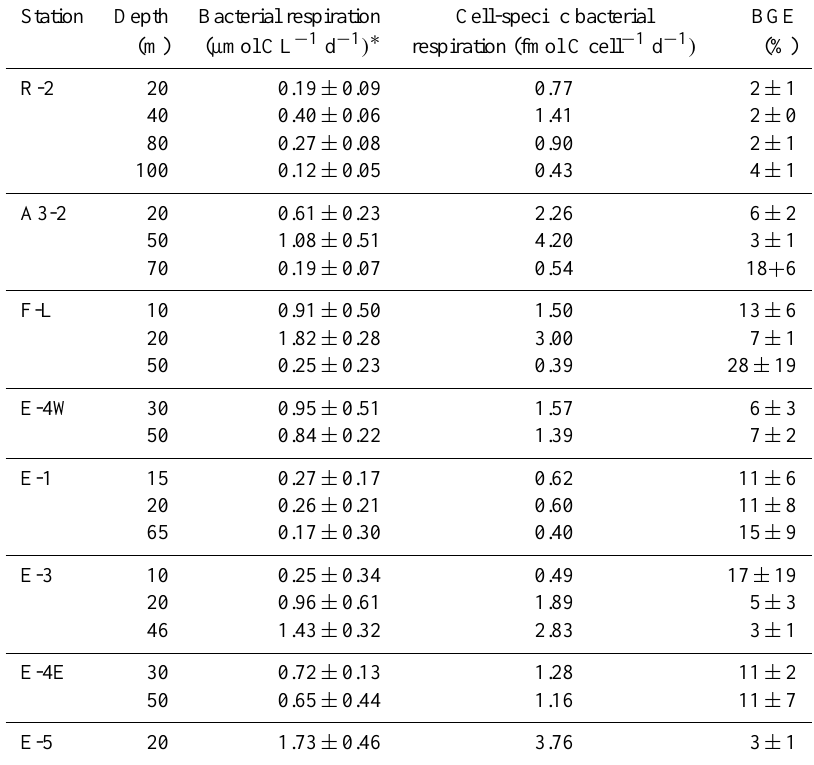
Table 5. Bacterial respiration, cell-specific bacterial respiration, and growth efficiency (BGE) in surface waters. Mean values ± SE are given. At station R-2, respiration rates of unfiltered samples were used. (*) Bacterial respiration rates have been converted from O 2 into C units using a RQ value of 1.